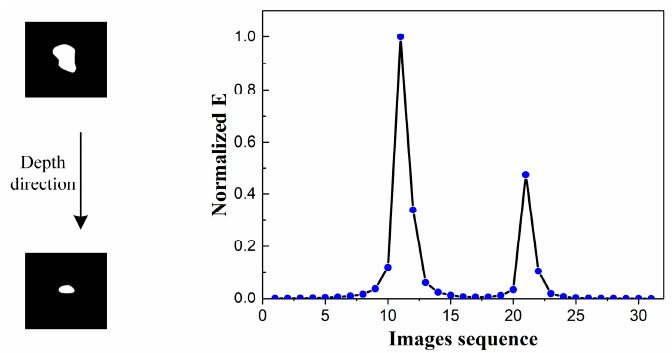
Figure 3. Definition curve of point defects.